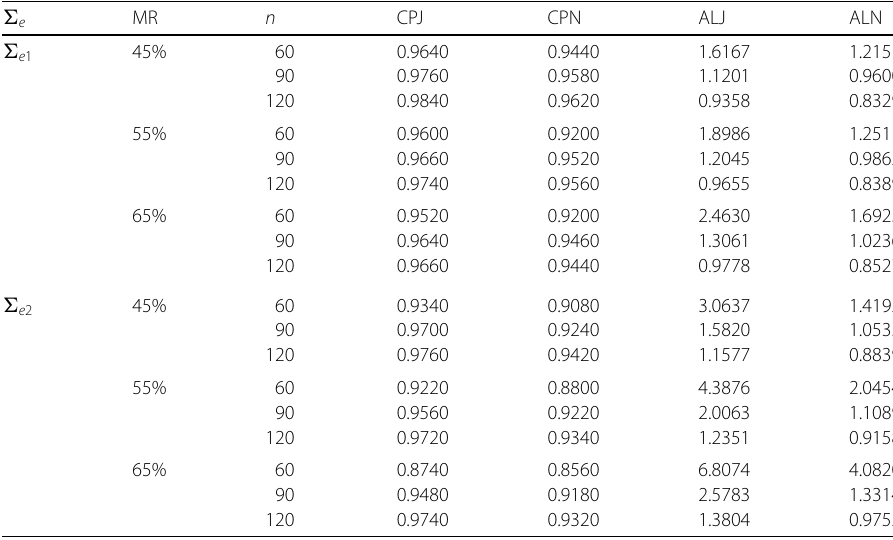
Table 3 CP and AL for JEL method and NA method on θ with confidence level 90%